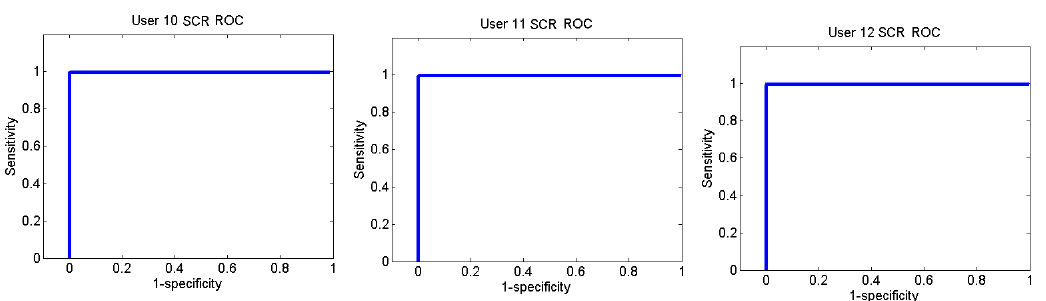
Figure 32. ROC curve of users 10, 11 and 12 from Sounds